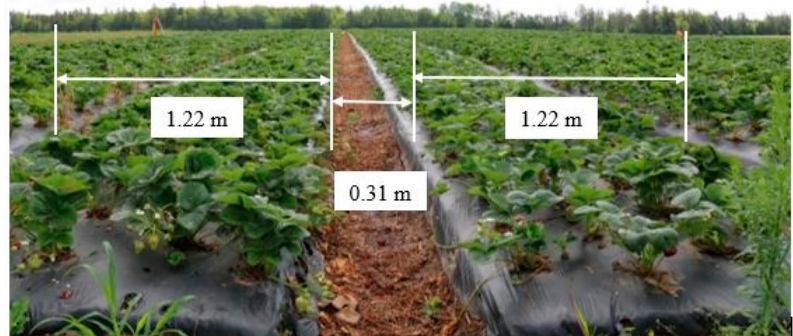
Figure 6. Experimental strawberry field (1.22 m in row width with a 0.31 m buffer between